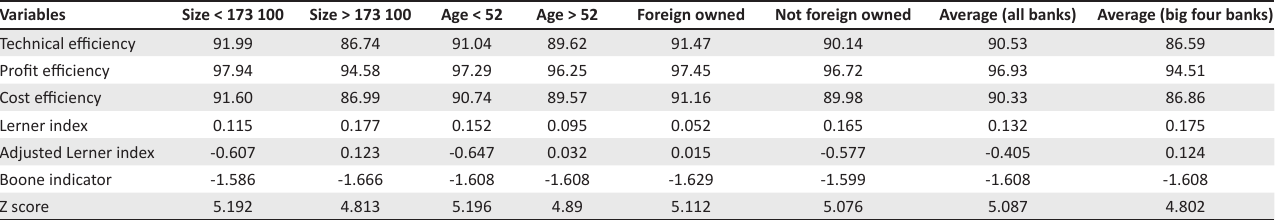
TABLE 5: Firm characteristics, efficiency and